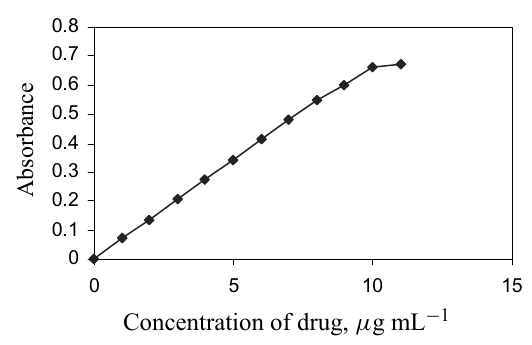
Fig. 3 – Beer’s law curve for method B.